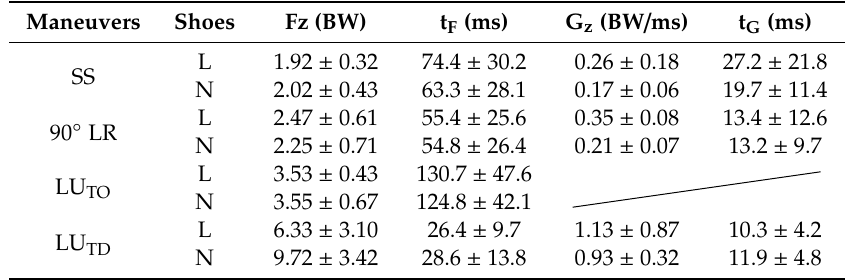
Figure 4. ( a ) Vertical ground reaction force-time curves during side-step cutting (SS) and 90 ◦ L-direction running (90 ◦ LR) maneuvers; ( b ) vertical ground reaction force-time curves during lay-up toe-o ff (LU TO ) and lay-up touch-down (LU TD ) maneuvers. Notes: GRF is ground reaction force, Fz is peak vertical GRF, and BW is bodyweight. Table 1. E ff ect of di ff erent basketball shoes on ground reaction force during side-step cutting, 90 ◦ L-direction running, and lay-up toe-o ff and lay-up touch-down maneuvers.